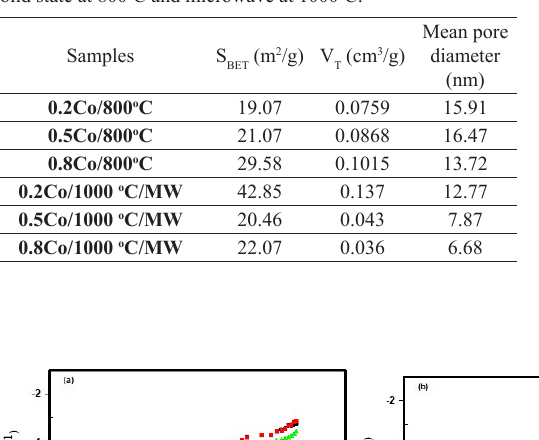
Table 2. Porous structure parameters determined by sorption at 77 K for Co-Zinc Ferrite with different Co content prepared by solid state at 800 o C and microwave at 1000 o C.